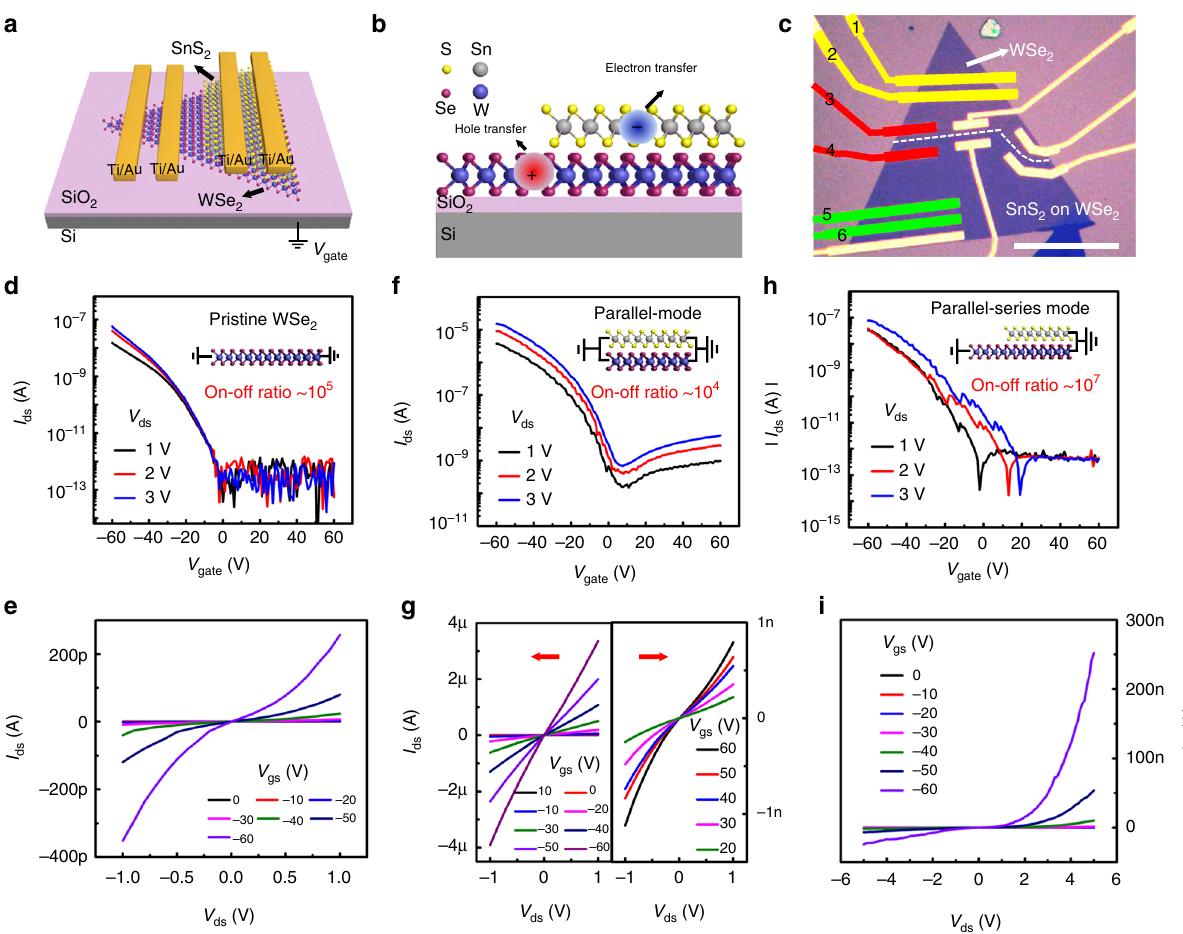
Fig. 4 Electrical characterization of the vertically stacked WSe 2 /SnS 2 heterostructure. a Schematic diagram of the multi-electrode WSe 2 /SnS 2 vdW heterostructure backgate device. b Front view of the WSe 2 /SnS 2 vdW heterostructure. c An optical image of fabricated WSe 2 /SnS 2 vdW heterostructure device. Scale bar, 60 μ m. d I ds − V bg curves of the pristine WSe 2 measured using electrodes 1 and 2, demonstrating p-type behavior. e I ds − V ds output characteristics of pristine WSe 2 FET at various backgate voltages. f I ds − V bg curves of the parallel-mode vdW heterostructure measured using electrodes 5 and 6, demonstrating ambipolar behavior. g I ds − V ds output characteristics of the parallel-mode vdW heterostructure at various backgate voltages from − 60 V to 10 V and from 20 V to 60 V. h I − V − n (SnS ds bg curves across the p (WSe 2 ) 2 ) heterojunction, named parallel-series mode, demonstrating p-type behavior (measured using electrodes 3 and 4). i I ds − V ds output characteristics across the p – n junction at different backgate − 1 − 1 is calculated to be 0.02 cm 2 V Figure 4b gives schematically the front view of the hetero- s ( L = 5.2 μ m, W = 36.5 μ m, structure, with electron dominating the charge transfer process in V ds = 1 V). In addition, the transport characteristic of the parallel-mode device shows ambipolar behavior (Fig. 4f), which the n-type SnS 2 layer and hole dominating transfer in the p-type WSe 2 layer, as reported in the literatures 44, 55 – 57 . The optical image of a typical WSe 2 /SnS 2 vdW heterostructure after device fabrication is shown in Fig. 4c. Electrodes 1, 2, and 3 were deposited on top of the pristine WSe 2 region, whereas electrodes 4, 5, and 6 were deposited on the top of the stack WSe 2 /SnS 2 − 1 − 1 calculated to be 10.1 cm 2 V region. As a result, three kinds of device channels were formed, s ( L = 4.25 μ m, W = 51 μ m, V ds = (1) pristine WSe 2 channel (electrodes 1 and 2, yellow), (2) parallel-mode channel (electrodes 5 and 6, green, bilayer stacked region) and (3) parallel-series mode channel (electrodes 3 and 4, red, heterojunction region), respectively. The transport characteristic of pristine WSe 2 shows typical p-type behavior, indicating that holes dominate charge transport process, with an on – off ratio of 10 5 and a threshold voltage of − 2 V (Fig. 4d). The corresponding output characteristic in Fig. 4e shows that the I ds decreases with the V g varying from − 60 to 0 V, and the I ds − V ds curves shows an in fl ection point at near V ds = 0 V, indicating the existence of a Schottky barrier at the WSe 2 contacting with Ti/Au. The fi eld-effect charge carrier mobility